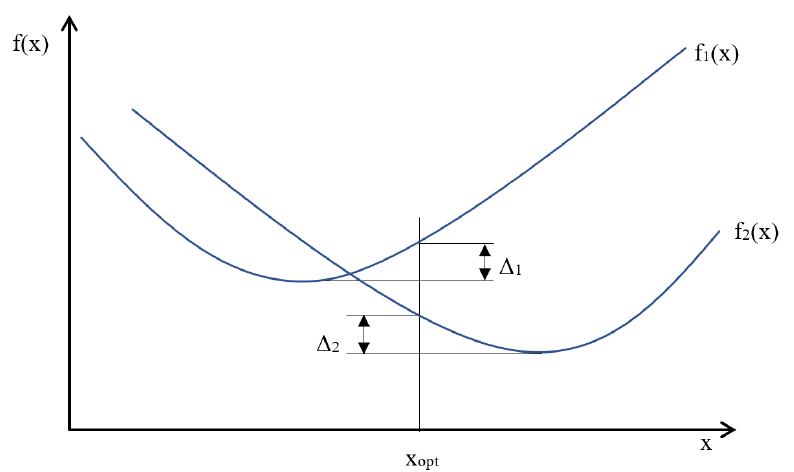
Figure 5. Pareto optimum example for two functions of one